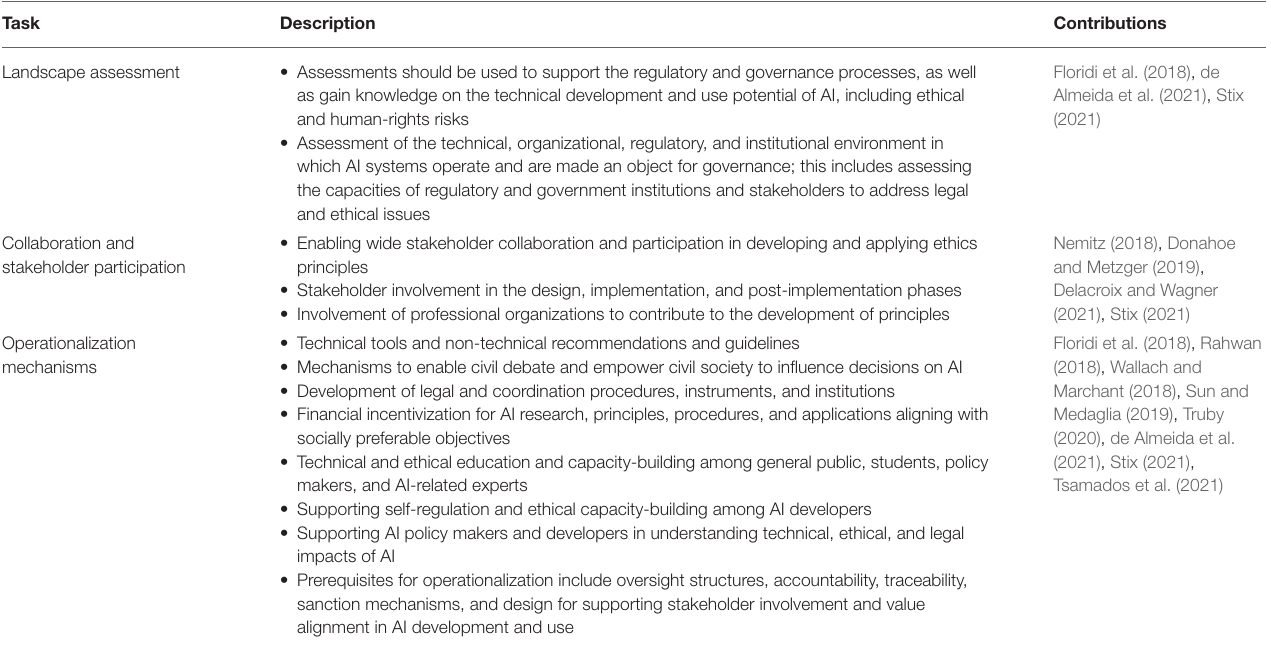
TABLE 4 | Actionability of ethical and human-rights